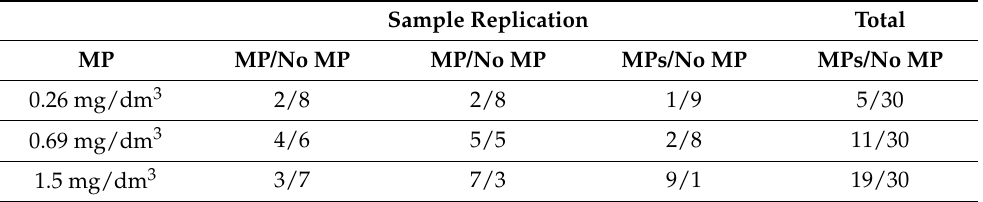
Table 1. Quantification of MPs in the digestive tract of Artemia salina. Number of organisms in which MP was detected (MP)/number of organisms in which MP was not detected (No